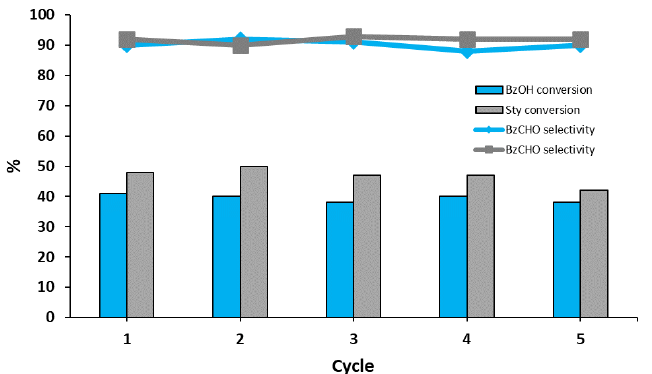
Figure 11. % Conversion is based on the substrate ( a benzyl alcohol/ b styrene); TBHP (0.15 mmol); temperature (90 °C/80 °C); O 2 balloon 1 atm; amount of Co/TSA-ZrO 2 ( a 100 mg/ b 150 mg); BzOH- temperature (90 ◦ C/80 ◦ C); O 2 balloon 1 atm; amount of Co/TSA-ZrO 2 (100 mg/150 mg); BzOH— Benzyl alcohol; Sty- Styrene; BzCHO- Benzaldehyde; BzCOOH- Benzoic acid. Benzyl alcohol; Sty—Styrene; BzCHO—Benzaldehyde; BzCOOH—Benzoic acid.